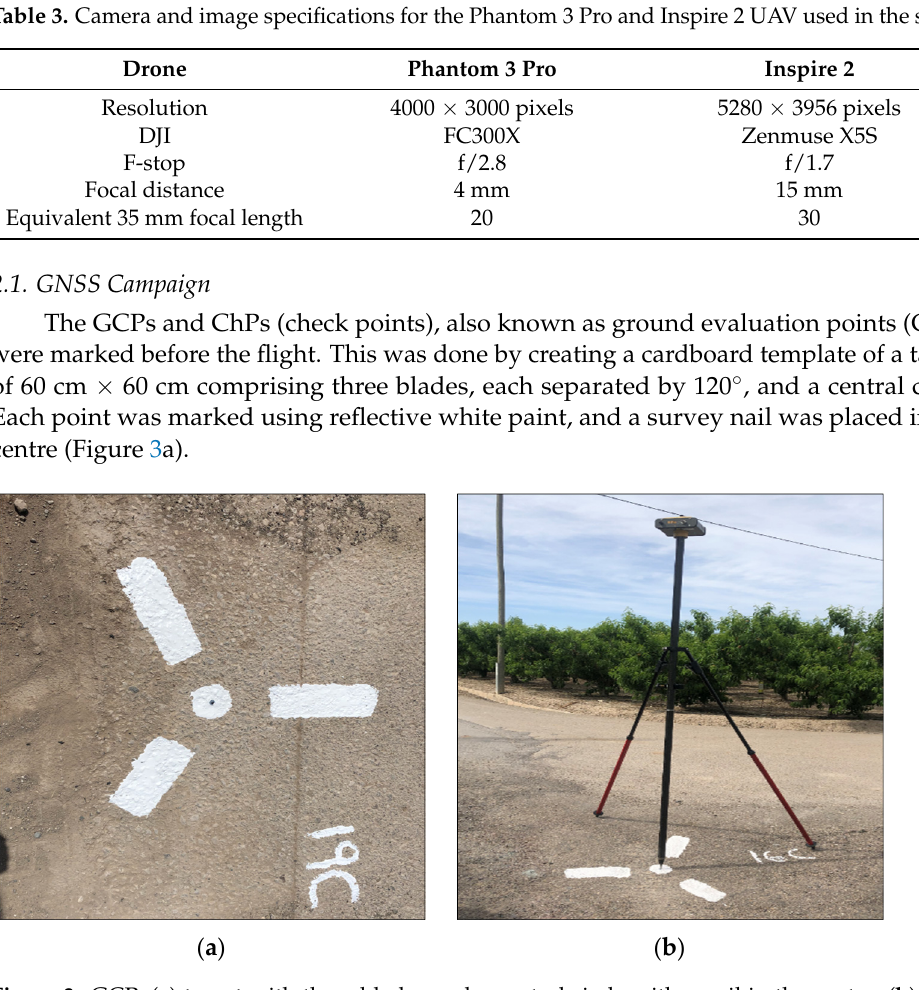
Figure 3. GCP: ( a ) target with three blades and a central circle with a nail in the centre; ( b ) dual-frequency GNSS receiver positioned on a tripod and centred on the point mark.